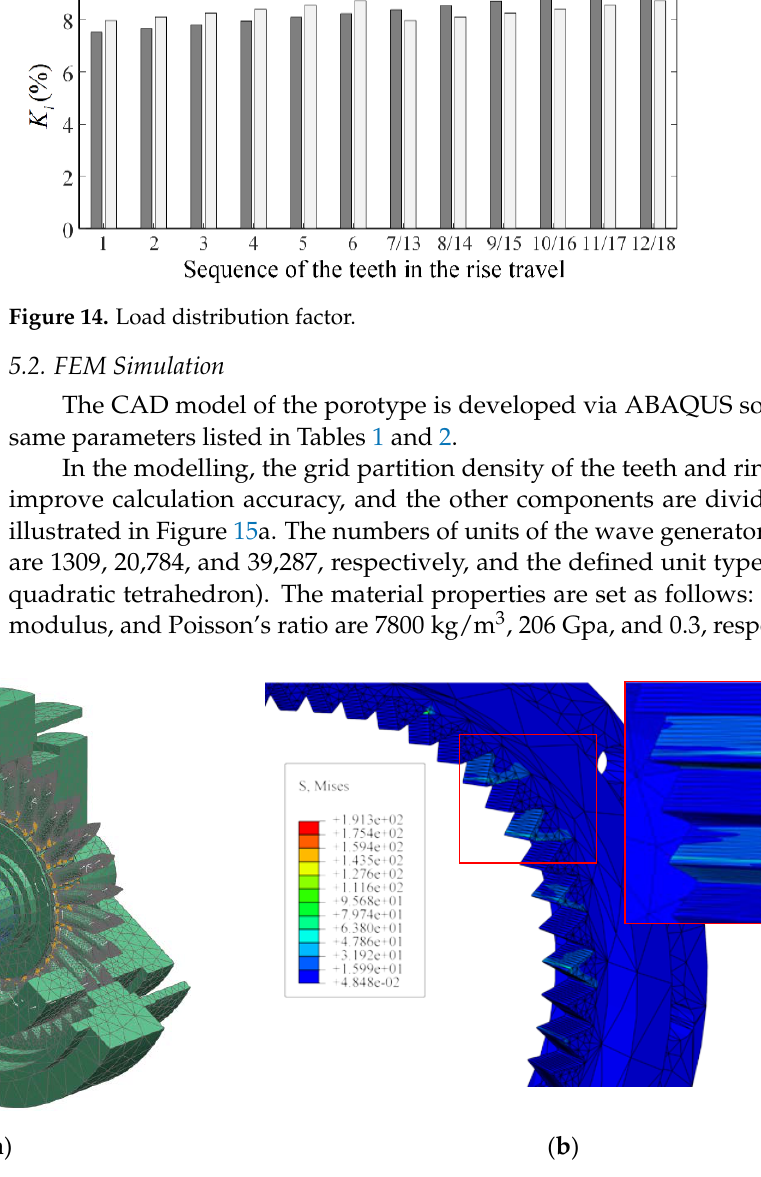
Figure 14. Load distribution factor.